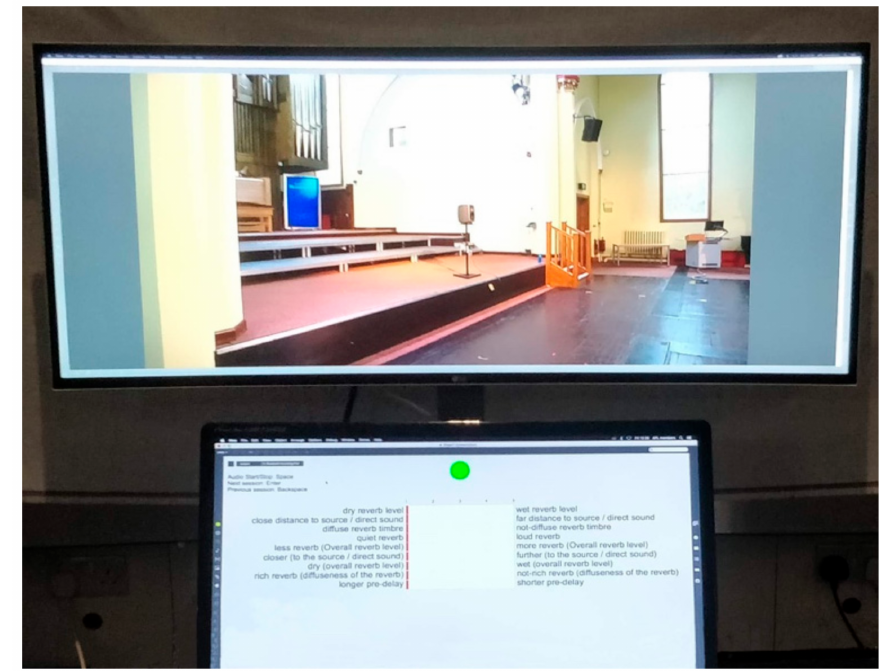
Figure 2. Laboratory elicitation